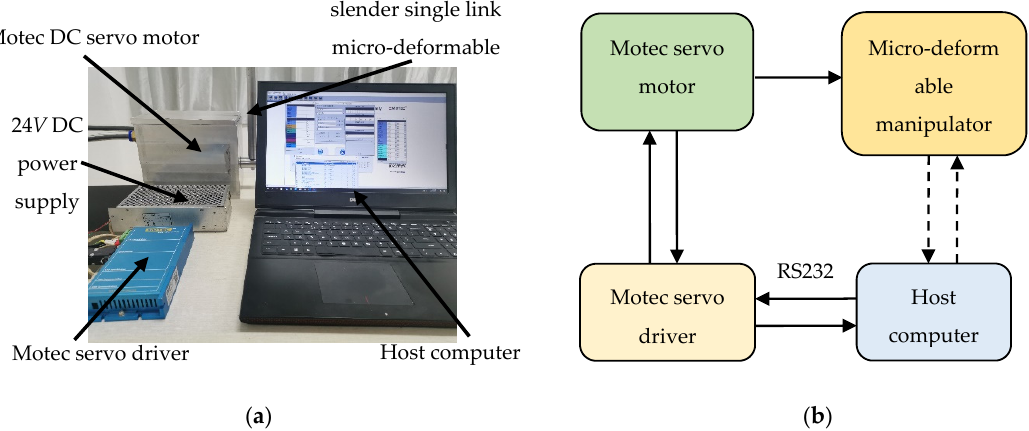
Figure 8. Experimental apparatus and schematic diagram: ( a ) experimental apparatus of the micro-deformable manipulator; ( b ) the schematic diagram of the experiment.